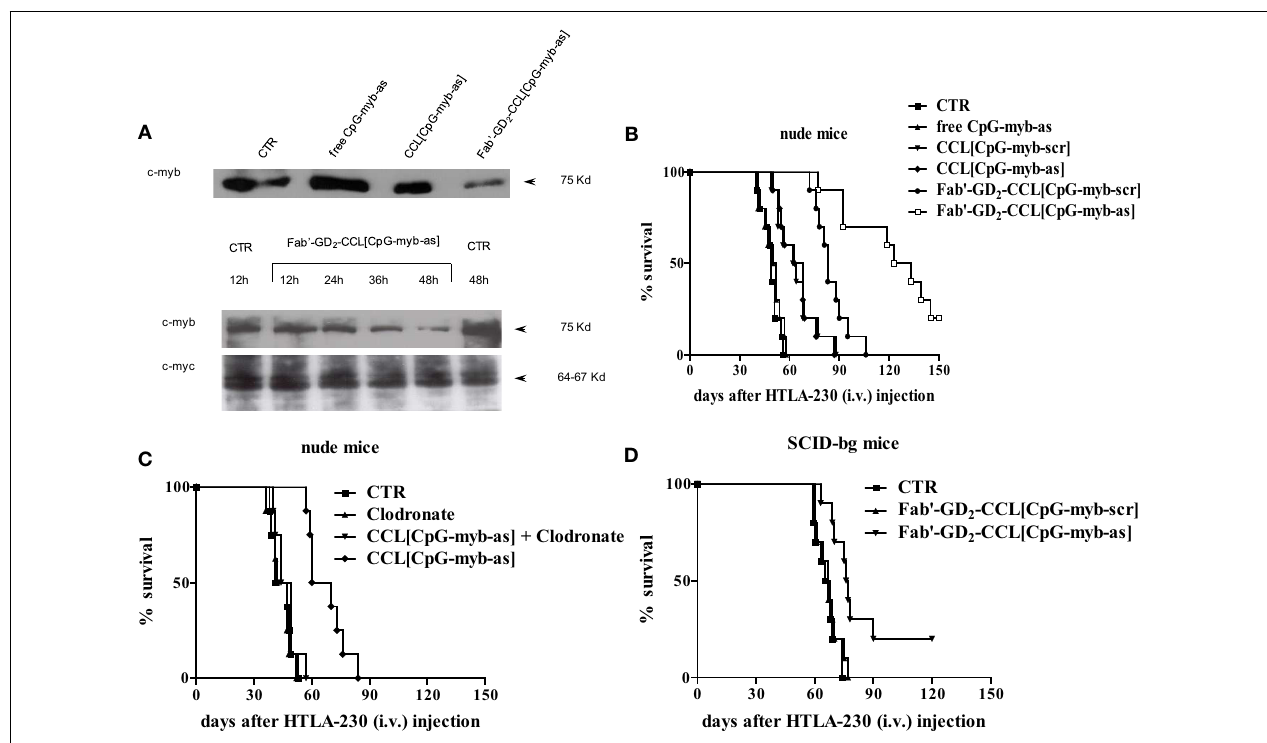
injected intravenously with 3.5 × 10 6 HTLA-230 cells.Treatment with either as or scrambled (scr), CpG-containing ODNs, administered free and encapsulated in untargeted (CCL) and targeted (Fab (cid:48) -GD 2 -CCL) liposomes was started at 4h after cell inoculation. Mice were treated 4days a week, for 2weeks, with 3day rest between treatments. Each mouse received 50 µ g ODN. Control mice (CTR) received HEPES-buffered saline. (C,D) Effects of either macrophages or natural killer (NK) cells depletion on anti-tumor activity mediated by treatment with liposomal formulations containing ODNs. Mice [nude, n = 8 animals/group (C) and SCID-bg, n = 10 animals/group (D) ] were inoculated with HTLA-230 cells and then treated as already mentioned in Figure 1 . In some treatment groups of (C) , mice were injected with Clodronate-liposomes to deplete